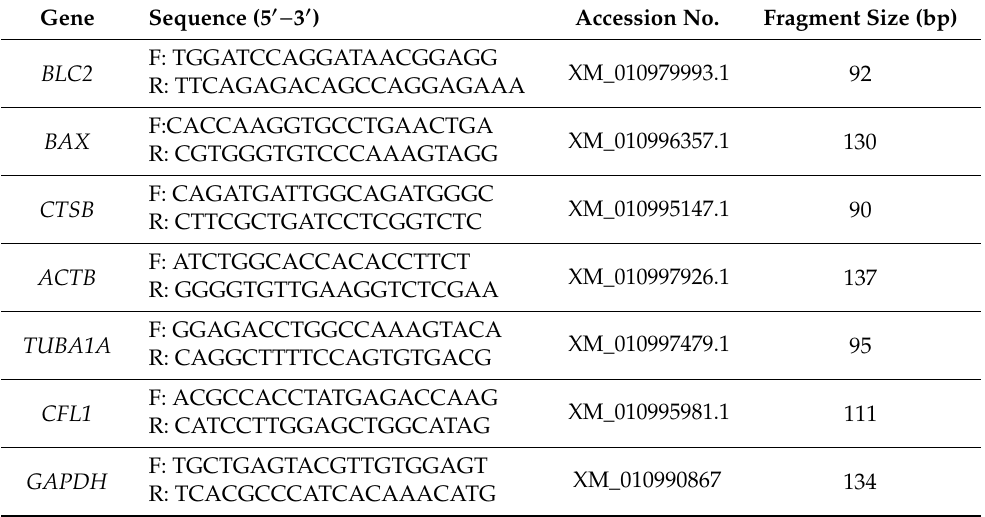
Table 1. Primer information used for real-time